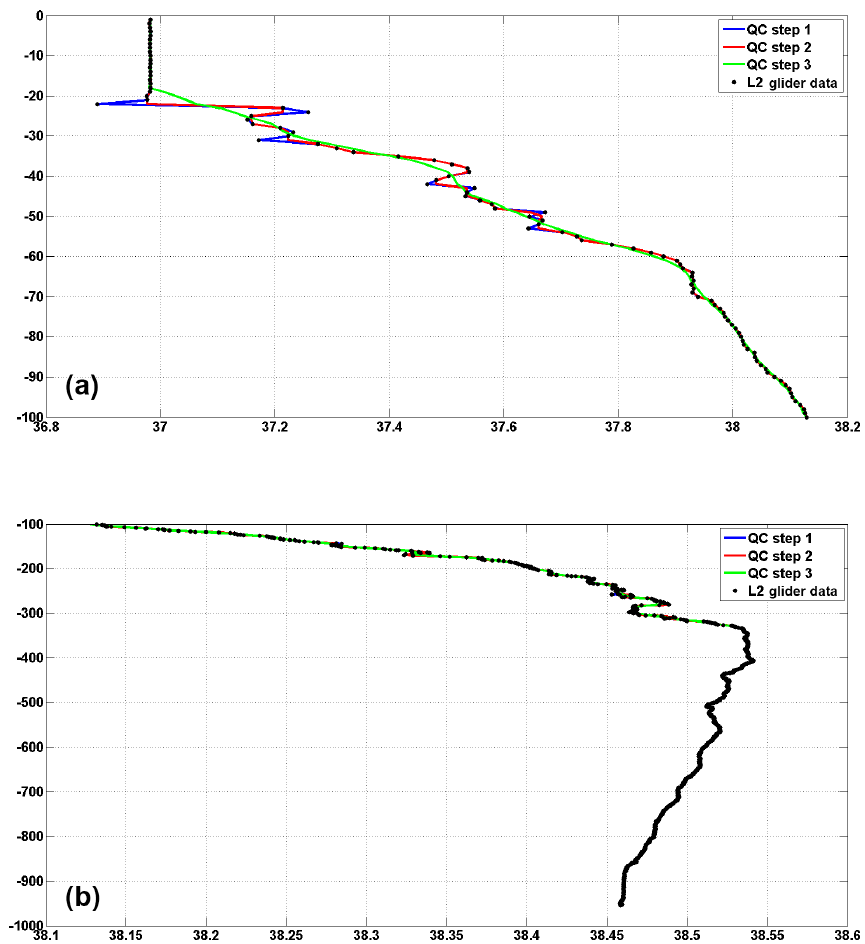
Figure 4. Effect of the additional quality control used to generate level 3 data. An example is shown for a salinity profile of the ABACUS 1 mission. The surface layer is shown in (a) (0–100m depth), while the intermediate and deep water layers are shown in (b) (from 100 to 975m depth). Black dots represent the original level 2 data after the standard quality control procedures, the blue line shows the single missing data interpolation, the median filter effect is shown by the red line and finally the green line represents the effect of the five-point running mean on the